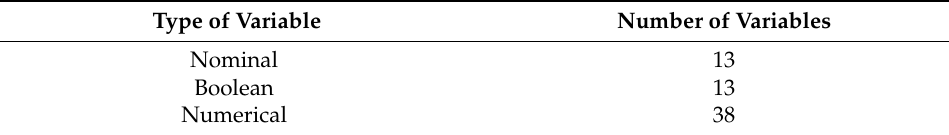
Table 4. The group of 64 variables chosen classified by their